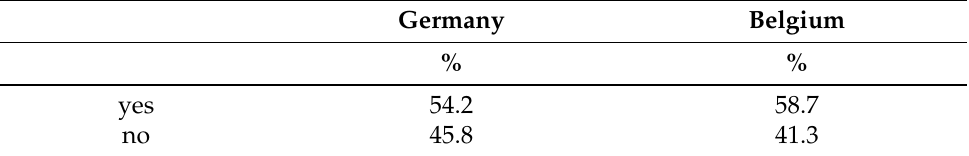
Table 8. Deliberate substitution of meat on the days respondents did not eat